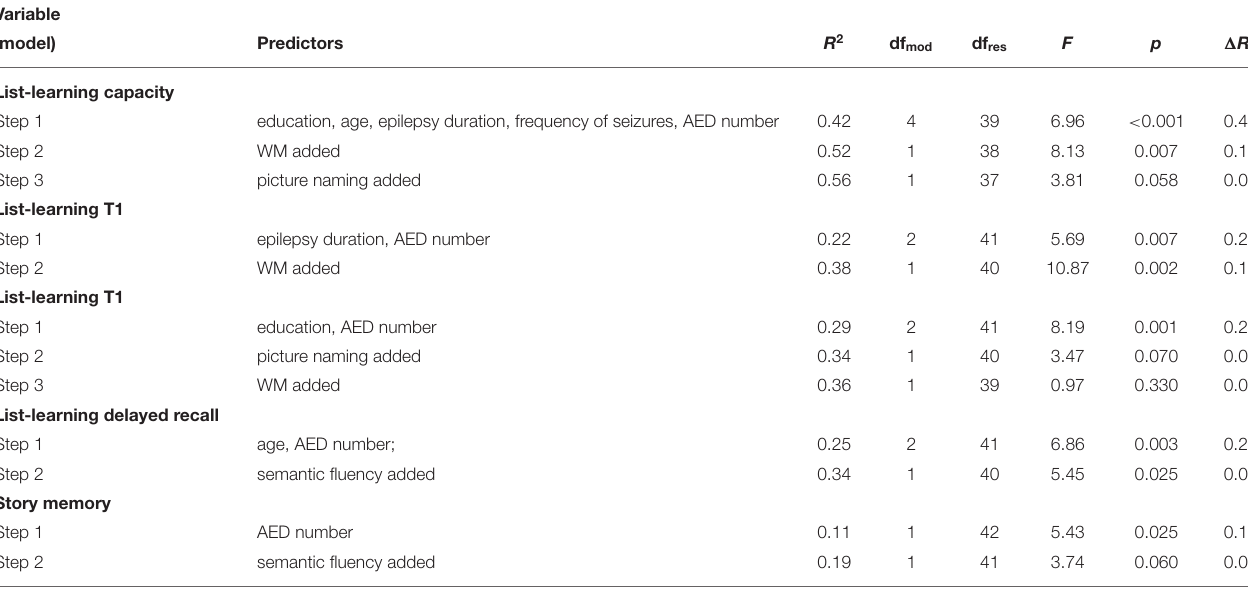
TABLE 2 | Model comparisons for variables predicting verbal learning and memory in LTLE. Variable